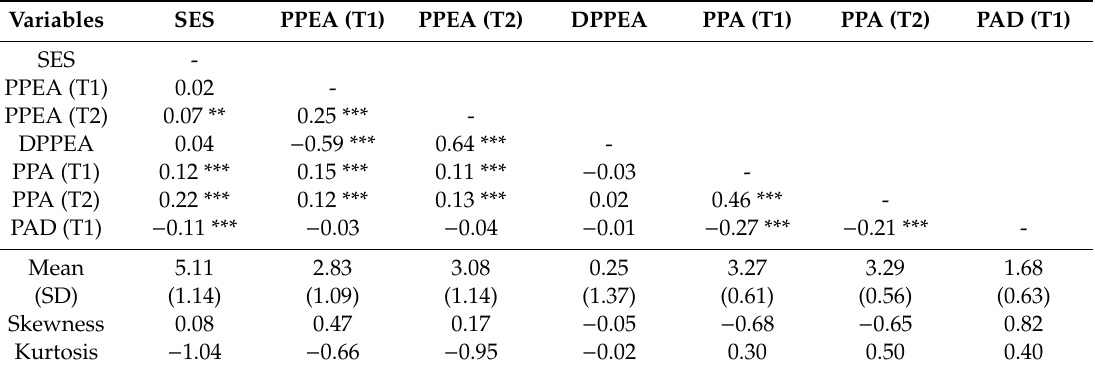
Table 1. Correlation and statistical analyses of observed variables for Cohort 1.